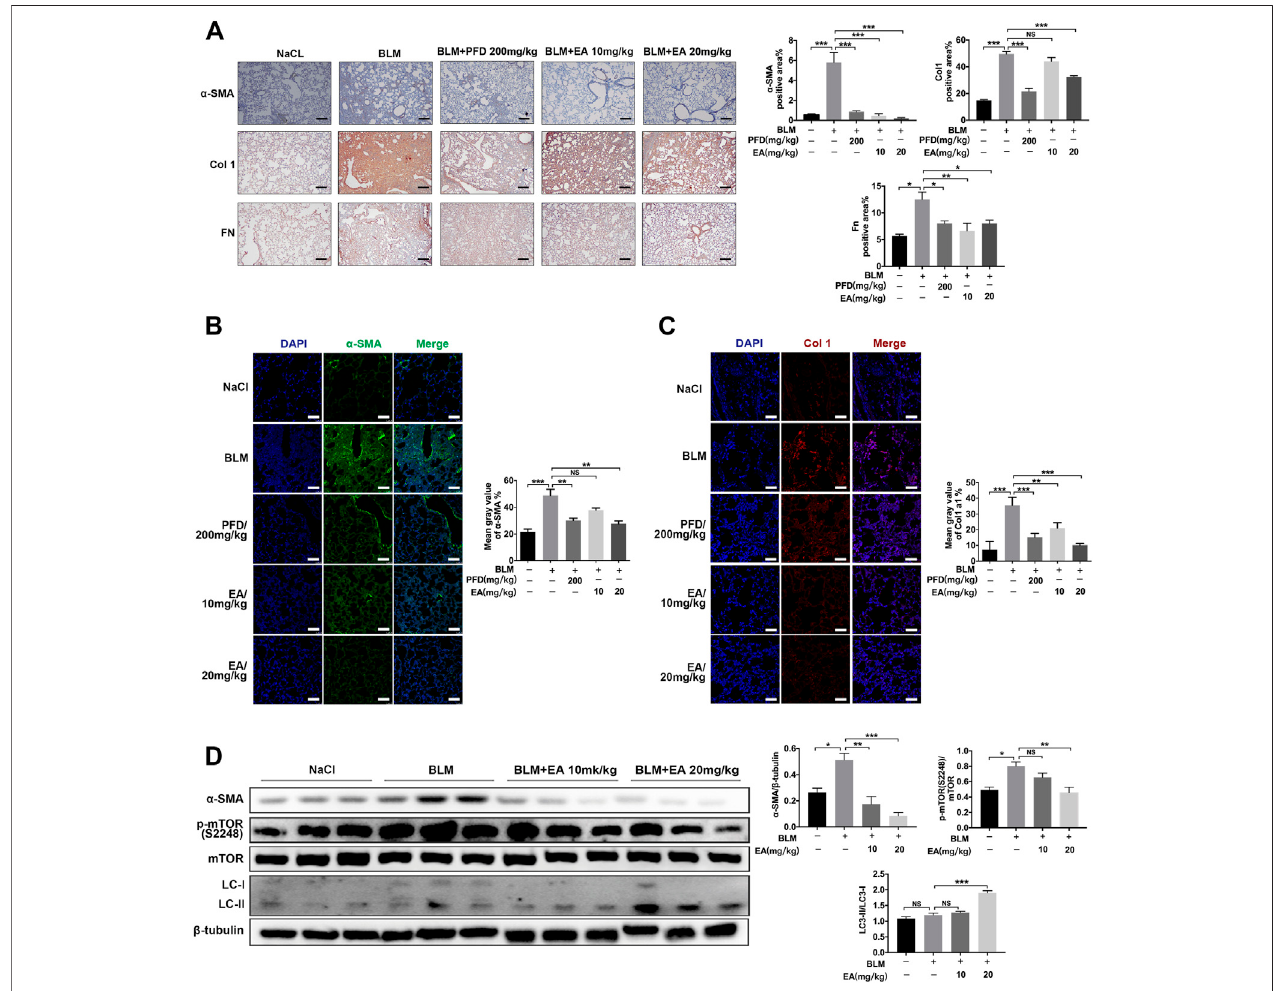
FIGURE 6 | Ellagic acid attenuates BLM-induced fi broblasts activation and ECM accumulation in vivo . The mice were treated with Ellagic acid (10 mg/kg, 20 mg/kg) from day 7 – 13 after administrating BLM (A) Immunohistochemistry was used to analyze the expression levels of α -SMA, Col1 and Fn ( n (cid:1) 3). Quantitative analysiswasshown beside. Scalebars:50 μ m (B – C) Theexpression levelsof α -SMAand Col1 weredetected byimmuno fl uorescence inlungsections. Theanalyses of mean gray value were shown beside. Scale bars: 50 μ m (D) Lung homogenization was used to analysis the α -SMA, LC3-II/I and p -mTOR (S2248), mTOR expression levels by Western blot ( n (cid:1) 6). Densitometric analyses were shown beside. Data in (A , D) are means ± Standard Error of Mean, * p < 0.05, ** p < 0.01, *** p < 0.001, and NS: nonsigni fi cant (one-way ANOVA). β -tubulin was used as a loading